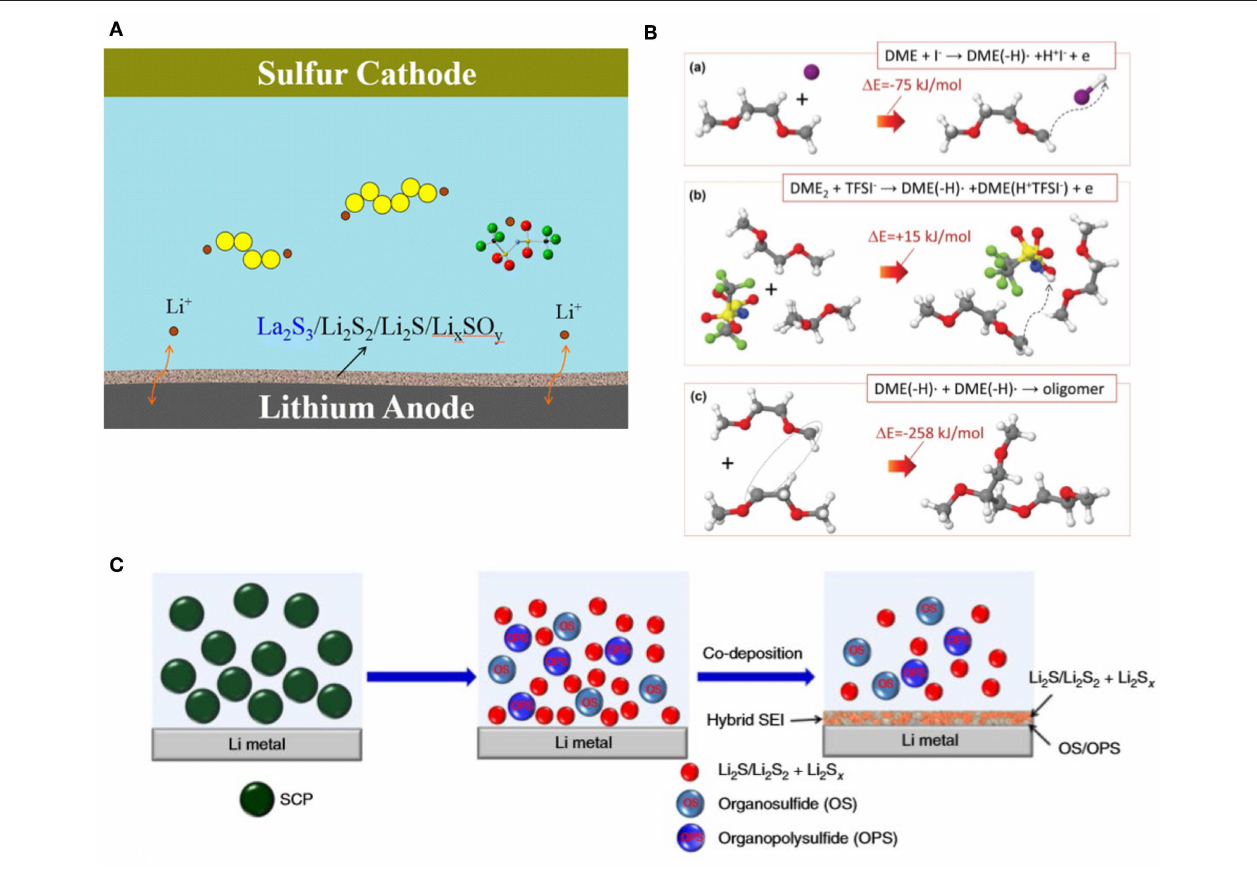
FIGURE 1 | (A) Schematic of passivation layer composition when adding La(NO 3 ) 3 additive (Liu S. et al., 2016) Copyright 2016 American Chemical Society. (B) Quantum chemistry calculations: formation steps of comb-branched polyether protective film (Wu et al., 2015a). Copyright 2015 John Wiley and Sons. (C) Schematic illustration of the SEI layer composition ( Li G. et al., 2017). Copyright 2017 Springer